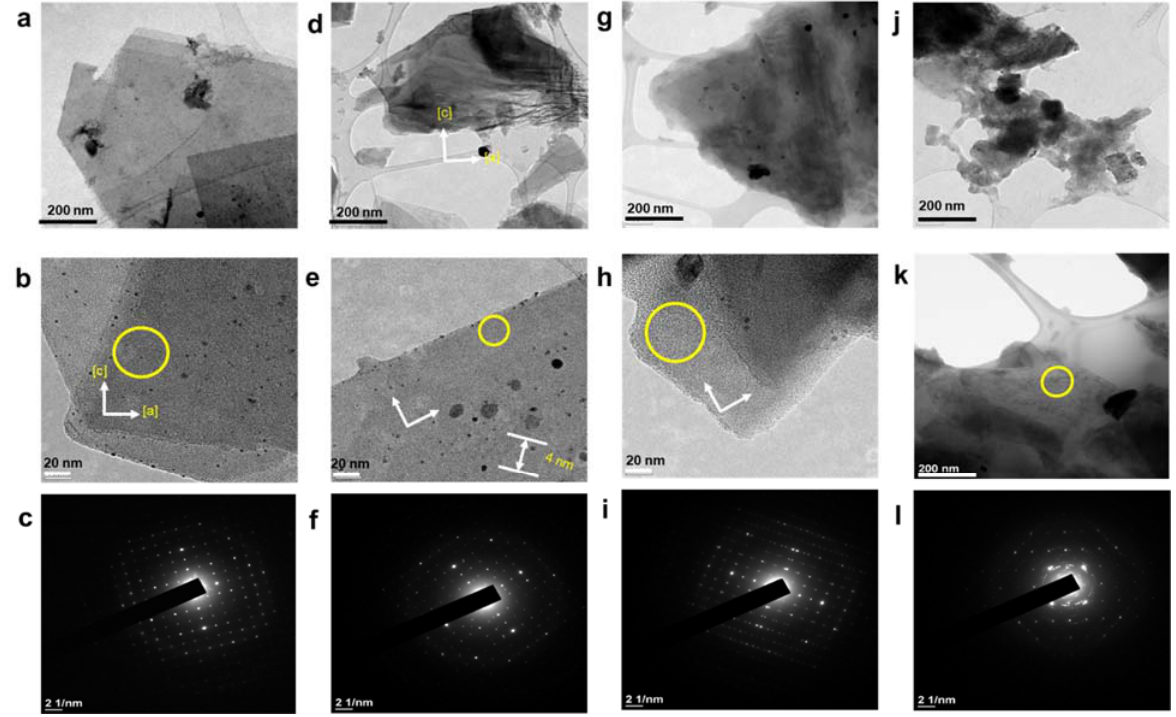
Figure 6. TEM images of exfoliated nanosheets after purification by repeatedly washing with toluene under centrifugation, ( a – c ) 10 wt.% suspension of nanosheets dispersed in n -butanol and corresponding SAED patterns of suspended nanosheets shows the few or single layers of nanosheets. The nanosheets were freely suspended in n -butanol solvent. ( d – f ), 10 wt.% suspension of nanosheets dispersed in o -DCB and the corresponding SAED pattern shows the few or single layers of nanosheets, ( g – i ) 10 wt.% suspension of nanosheets dispersed in N (cid:48) N (cid:48) DMF and the corresponding SAED patterns, ( j – l ) 10 wt.% suspension of nanosheets dispersed in chloroform and the corresponding SAED patterns. Table 1. Molecular weight, kinetic diameter, steric hindrance and molecular structure of organic solvents.